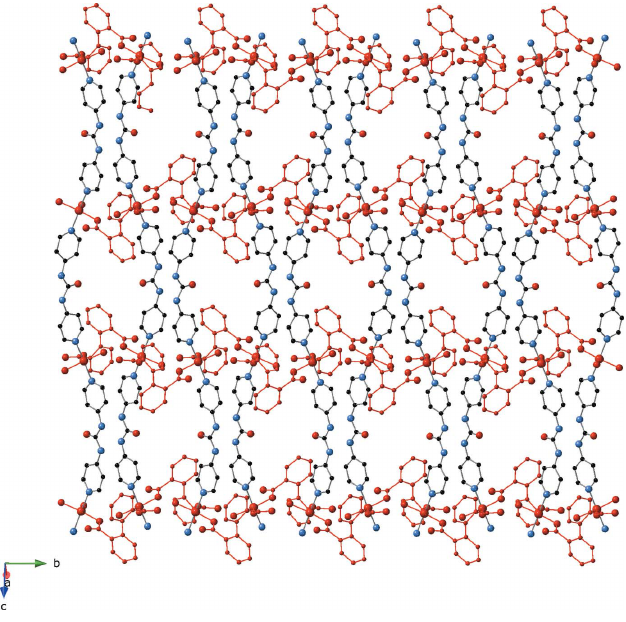
Figure 3 A face-view perspective of the two-dimensional [Cu(H 2 O)(dip)(bpu)] n coordination polymer layer motif in the title compound. [Cu(H 2 O)(dip)] n chain motifs are drawn in red.